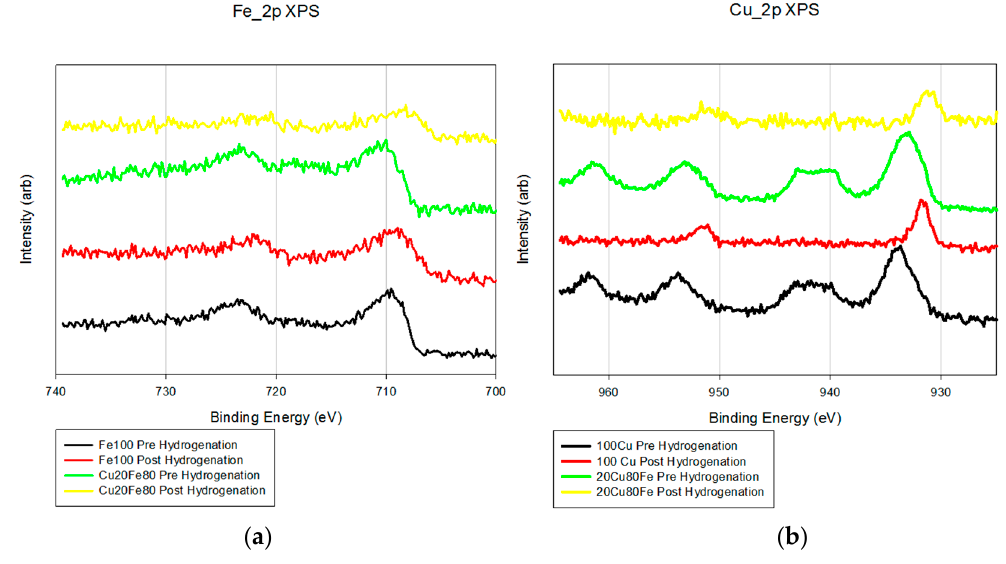
Figure 2. X-ray photoelectron spectroscopy data for both ( a ) Fe_2p and ( b ) Cu_2p.